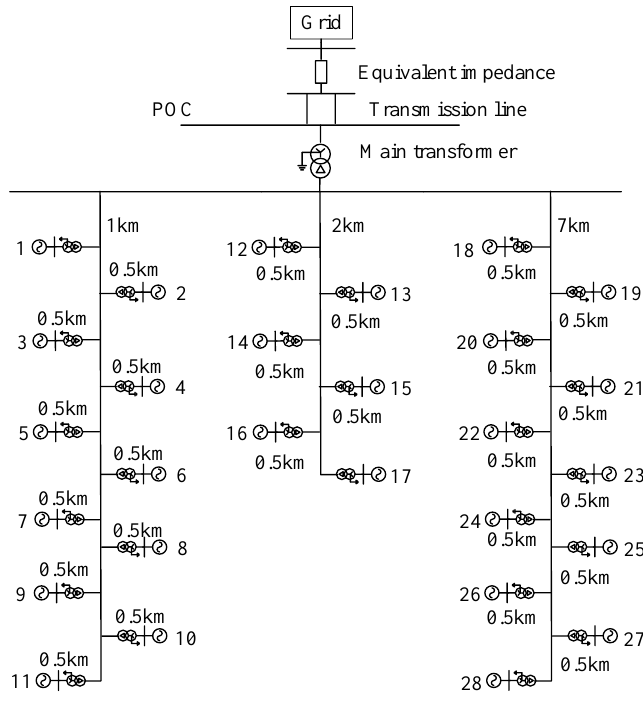
Figure 3. DFIG-based WF topology.